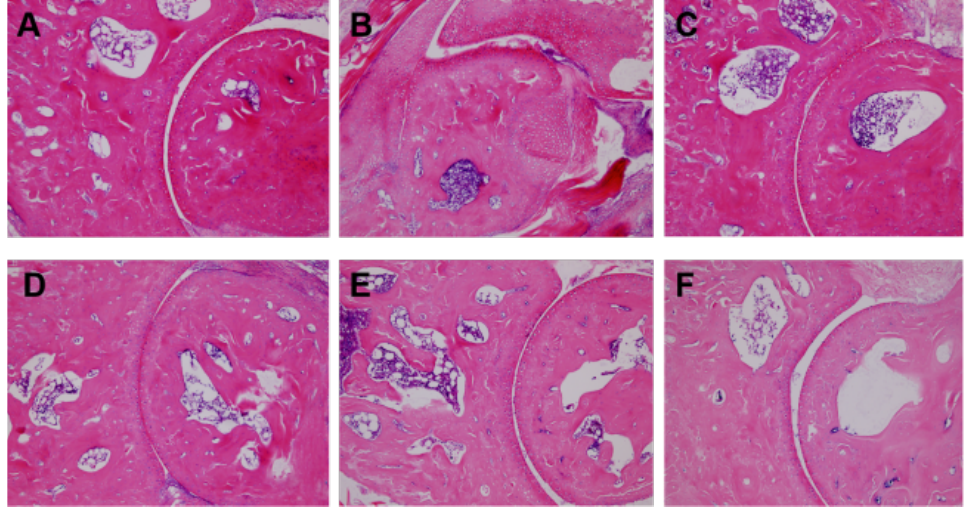
Figure 10. Hematoxylin-eosin staining of bone and synovial slices in each group (magnification 100×): ( A ) control group, ( B ) model group, ( C ) 0.5 mg/kg TP group, ( D ) 0.5mg/kg TP-CMCS group, ( E ) 1 mg/kg TP-CMCS group, and ( F ) 2 mg/kg TP-CMCS group.